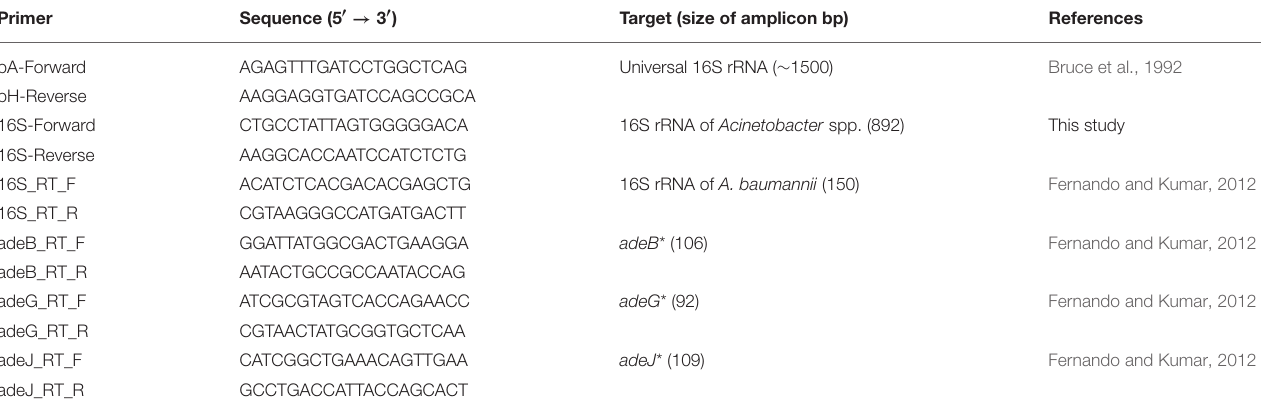
TABLE 2 | Primers used in this